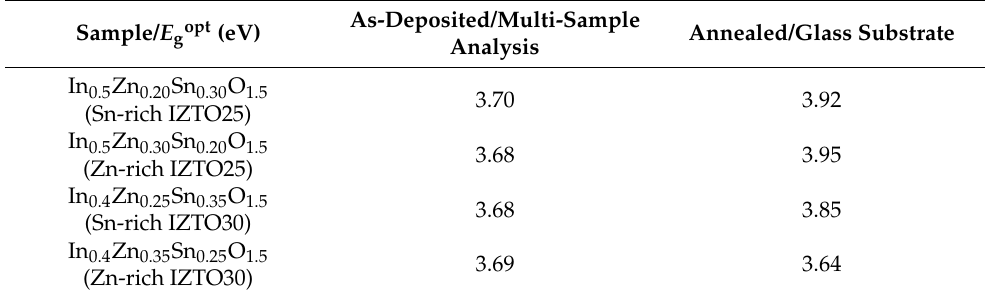
Table 2. Optical bandgap of as-deposited and annealed non-stoichiometric IZTO layers determined from Tauc plot. Sample/ E gopt